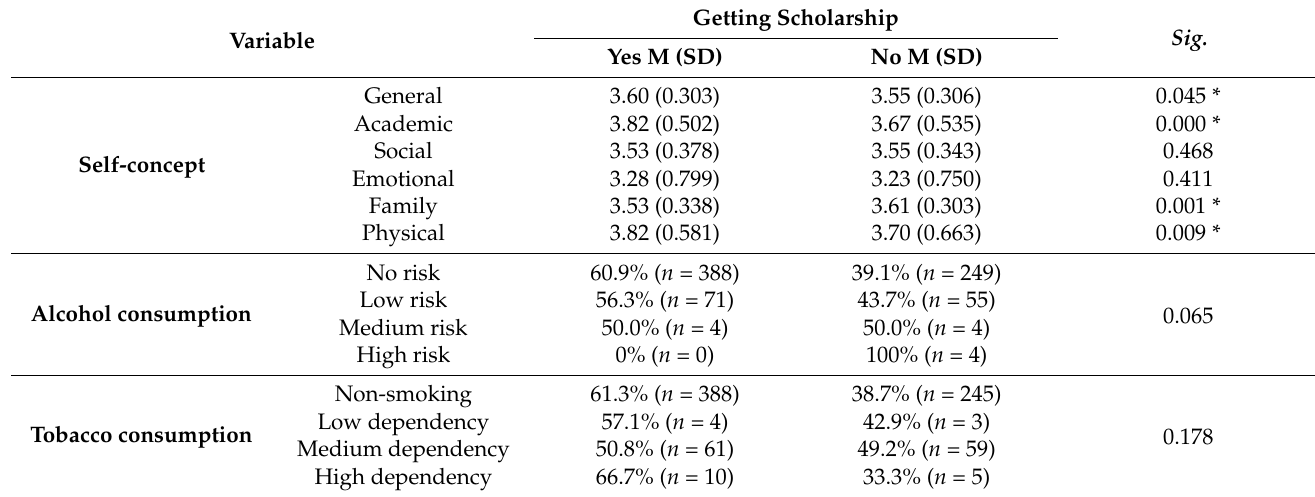
Table 4. Psychosocial factors according to getting